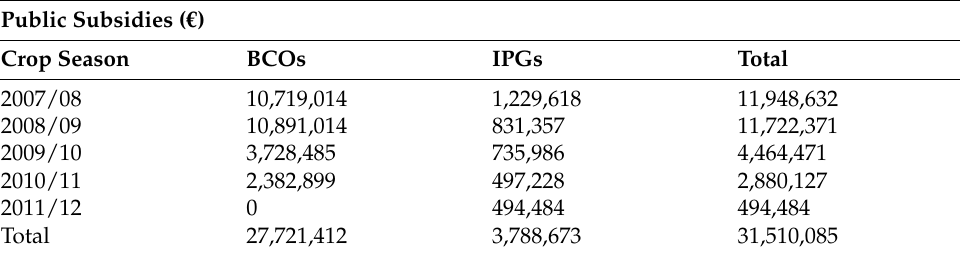
Table 6. Public subsidies paid for the biological control of protected horticultural crops in Almer í a.